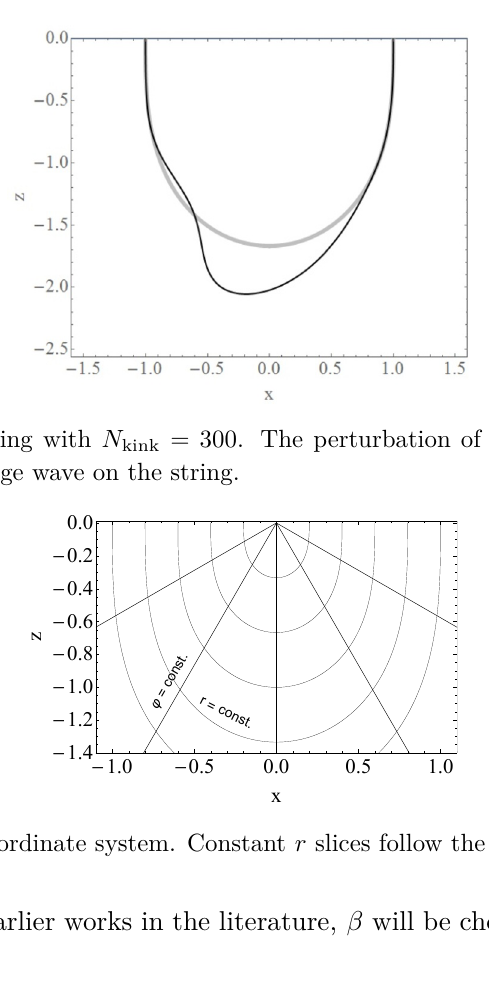
Figure 6 . Compactly supported smooth function β ( t ) for moving one of the string endpoints.